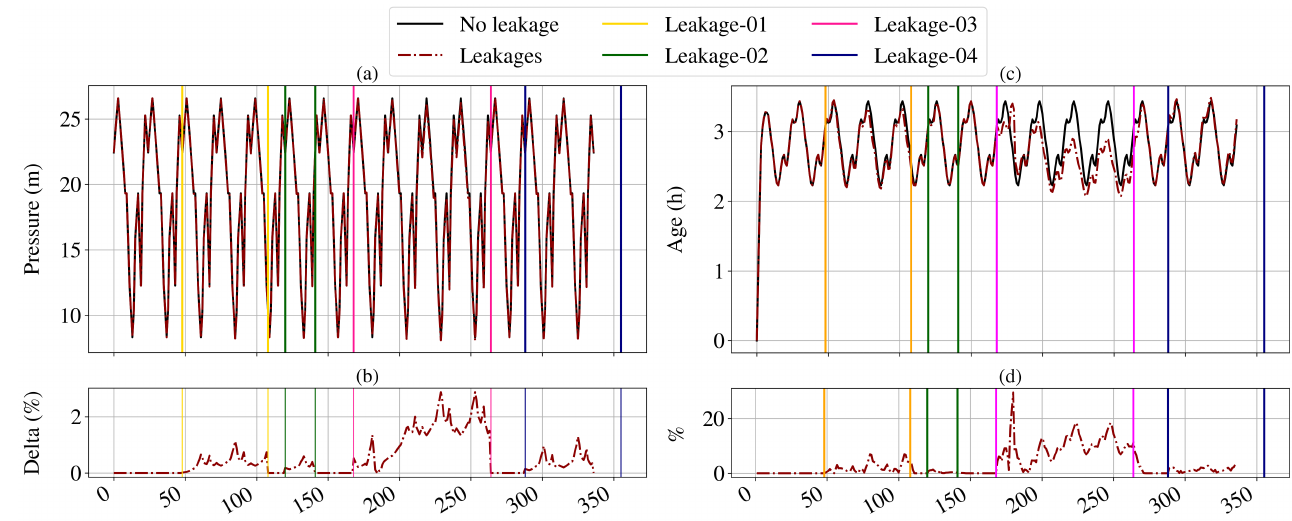
Figure 6. Sensitivity of node 153 for leaks in scenario C: ( a ) Pressure variation, ( b ) Pressure variation delta, ( c ) Quality variation and ( d ) Quality variation